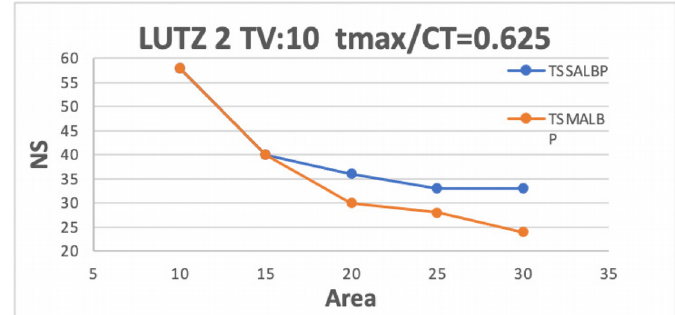
Figure 4. The number of stations plotted against the area for Lutz 2 instance with moderate TV and T